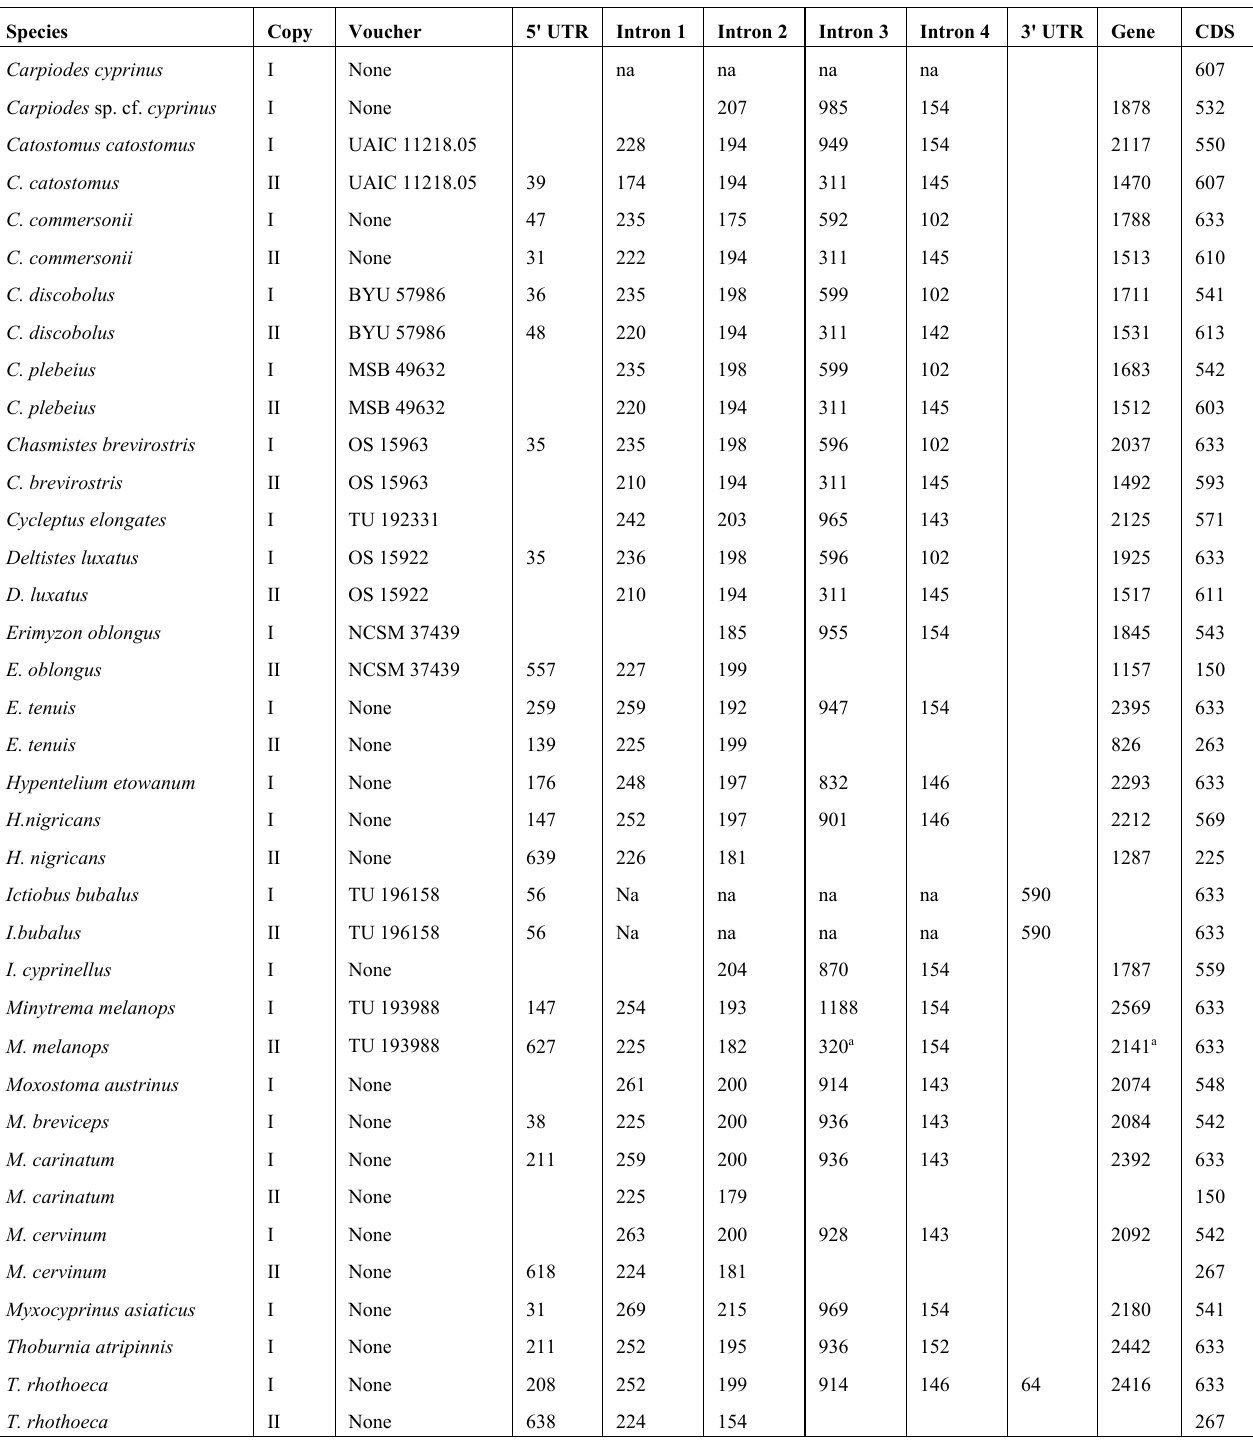
Table 2. Genomic organization of GH gene in suckers includes length of UTRs, introns, GH fragment sequenced (Gene), and coding sequence (CDS). Museum vouchers are included when